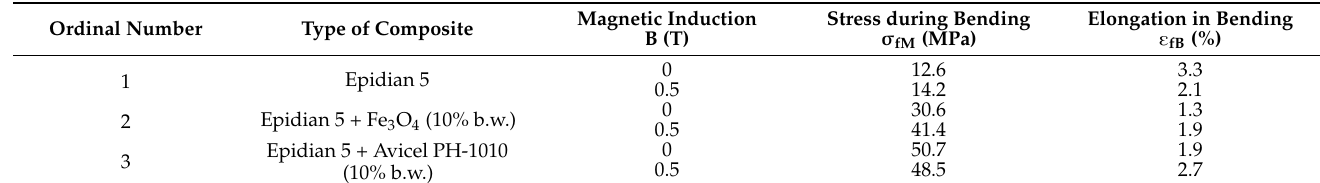
Table 10. Comparison of the mechanical bending strength of composites.